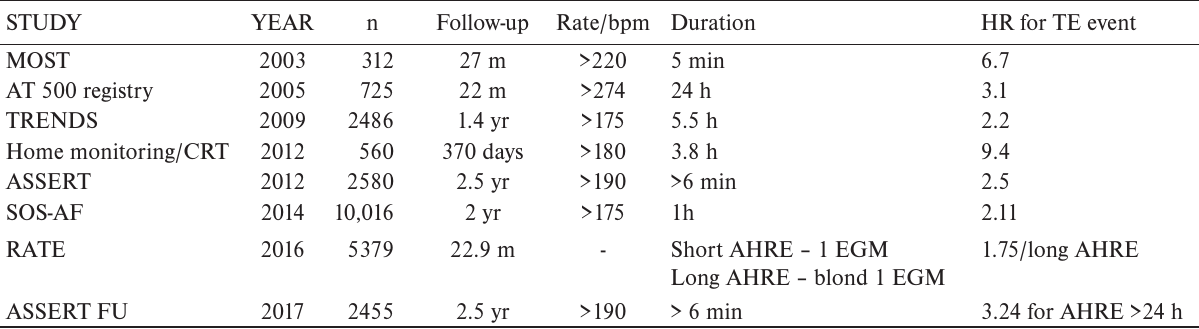
Table 2. SCAF trials characteristics according to AHRE frequency, follow-up and thromboembolic risk.